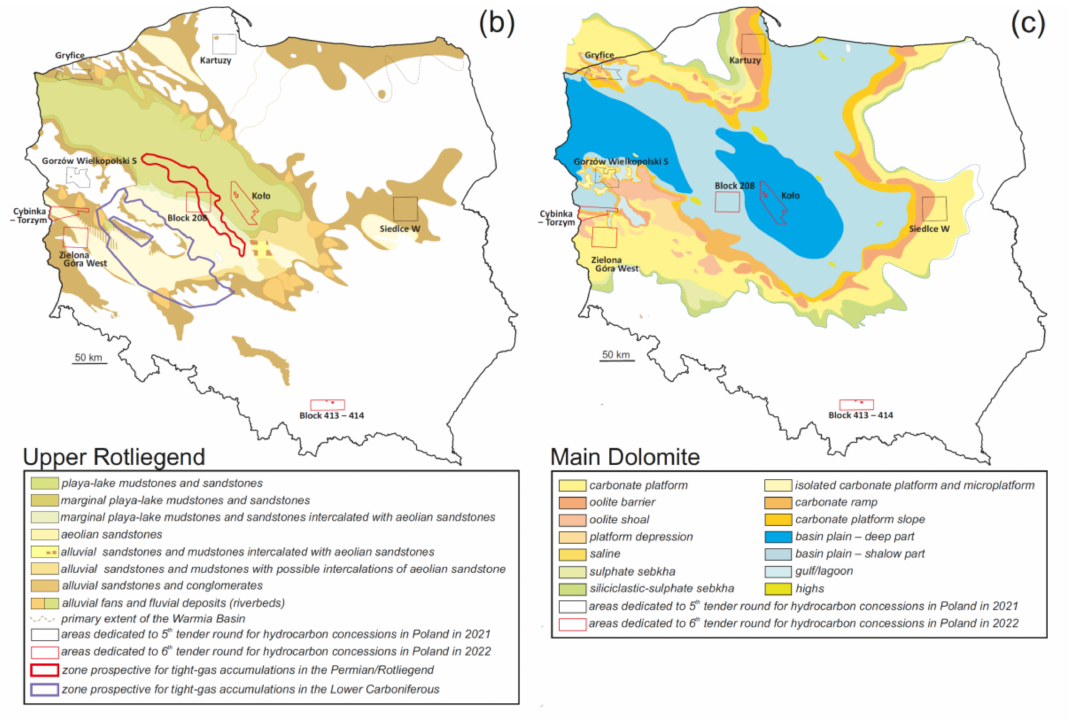
Figure 4. Location of the areas dedicated to the 5th and 6th tender rounds for hydrocarbon conces- sions: ( a ) on the Geological map of Poland without Cenozoic deposits ([54], simplified); ( b ) in relation to the Upper Rotliegend facies distribution [55] and prospective zones for tight-gas accumulations in the Permian/Rotliegend and Lower Carboniferous [27]; ( c ) in relation to the Permian/Zechstein Main Dolomite facies distribution